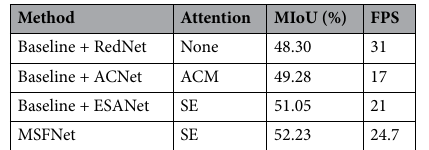
Table 1. Ablation experiment of fusion